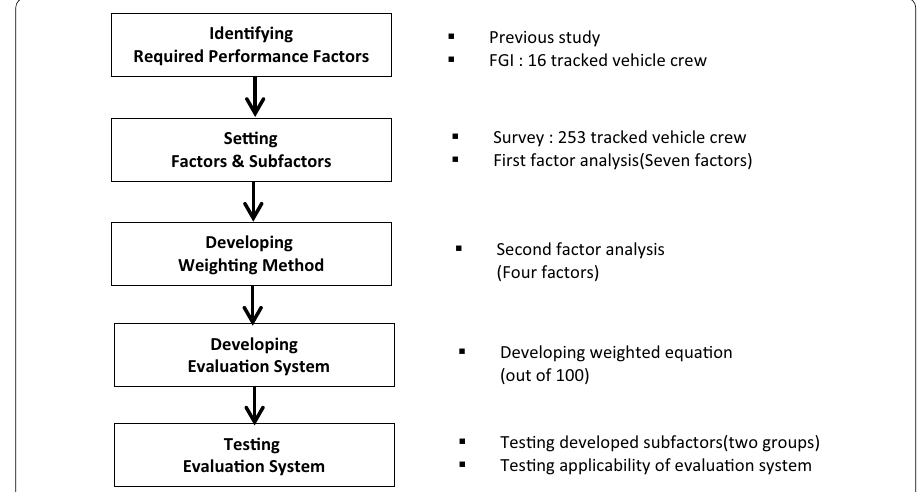
Fig. 1 A flow chart for the evaluation system development